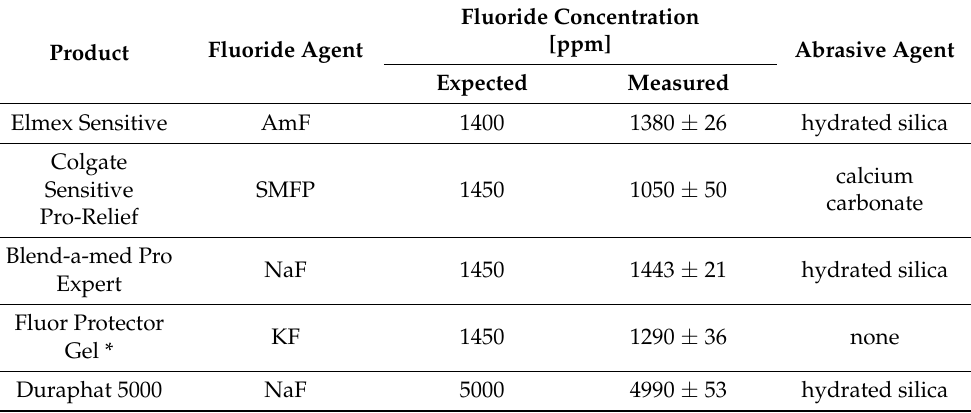
Table 1. Information about product formulation, including fluoride agents, abrasive agents, fluoride concentration declared on label [ppm], ionic fluoride measured in lab analysis (mean ± standard